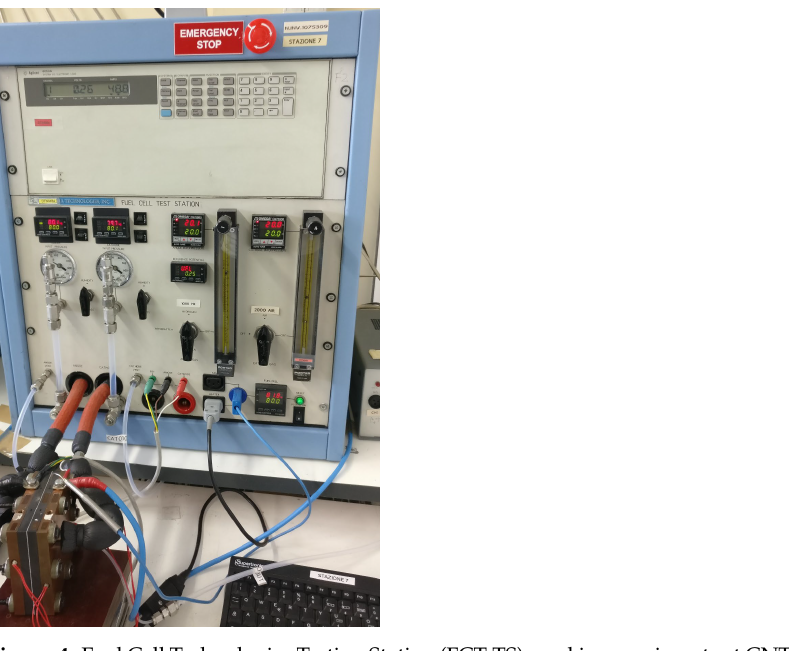
Figure 4. Fuel Cell Technologies Testing Station (FCT-TS) used in experiments at CNT-ITAE laboratories. The maximum current of Metrohm AUTOLAB PGSTAT302N potentiostat/galvanostat (Utrecht, The Netherlands) is 2 A. This value allows analyzing a very restricted part of the polarization curve, so the PGSTAT302N was connected with the BOOSTER20A booster (Metrohm AG, Herisau, Switzerland), which extends the maximum current up to 20 A. The frequency range for the EIS measurement was set from 0.1 Hz to 10 kHz, with 10 logarithmically distributed frequency values for decade, and six different points of the polarization curve, precisely for 1 A, 4 A, 5 A, 7 A, 10 A and 15 A current values for the fuel cell active area of 25 cm 2 are considered. The corresponding current densities are: 0.04 A cm − 2 , 0.16 A cm − 2 , 0.20 A cm − 2 , 0.28 A cm − 2 , 0.40 A cm − 2 and 0.60 A cm − 2 . Three different measurements were taken for each working point. The investigation aims to obtain a model of the process by using the obtained experimental measures. Only measurements in the range 0.1 Hz to 1000 Hz are considered to avoid parasitic inductive effects, which start from 1 kHz. The obtained experimental Bode diagrams are reported in Figure 5.